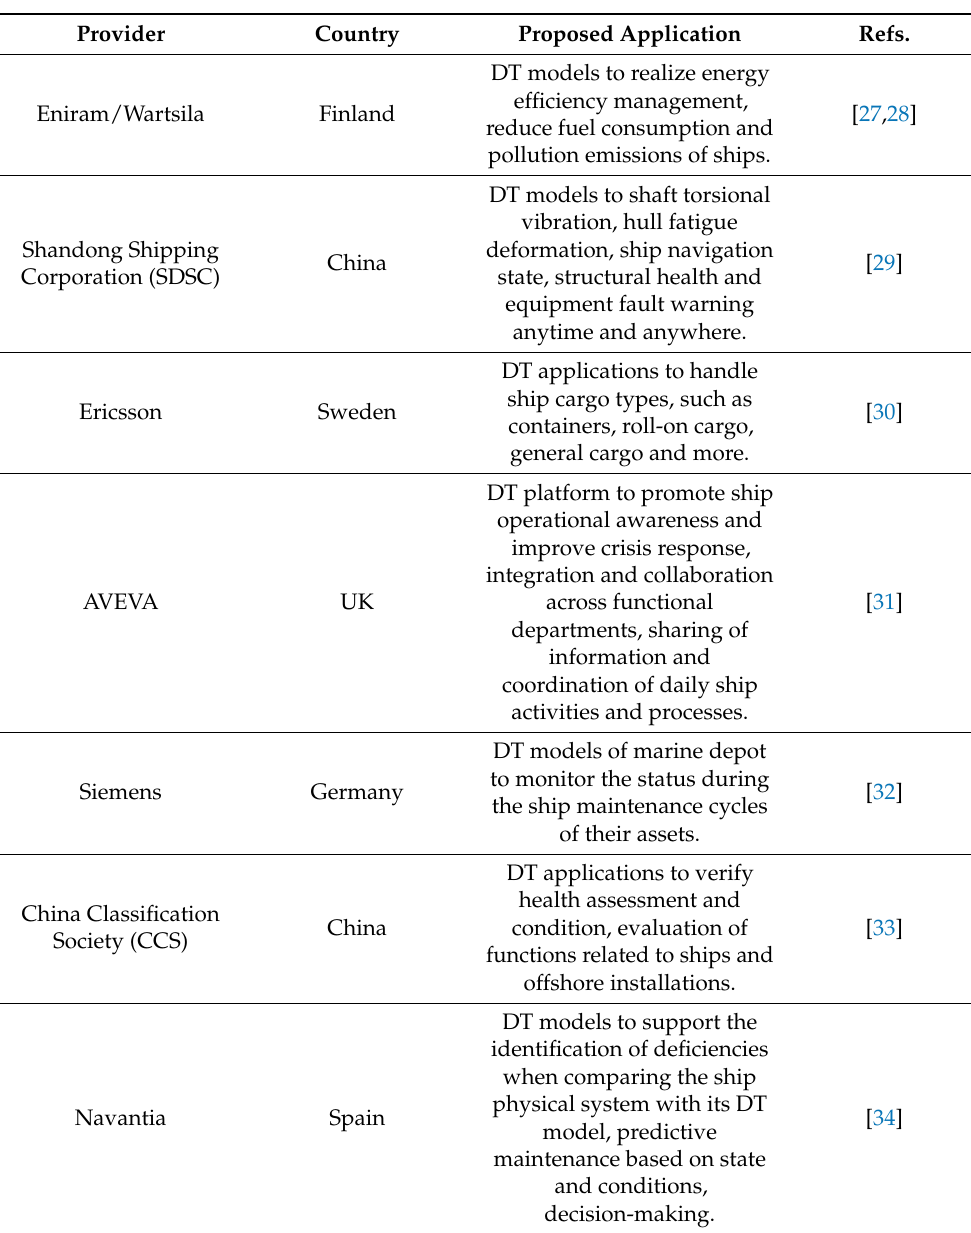
Table 3. Main providers and DT applications in the ship